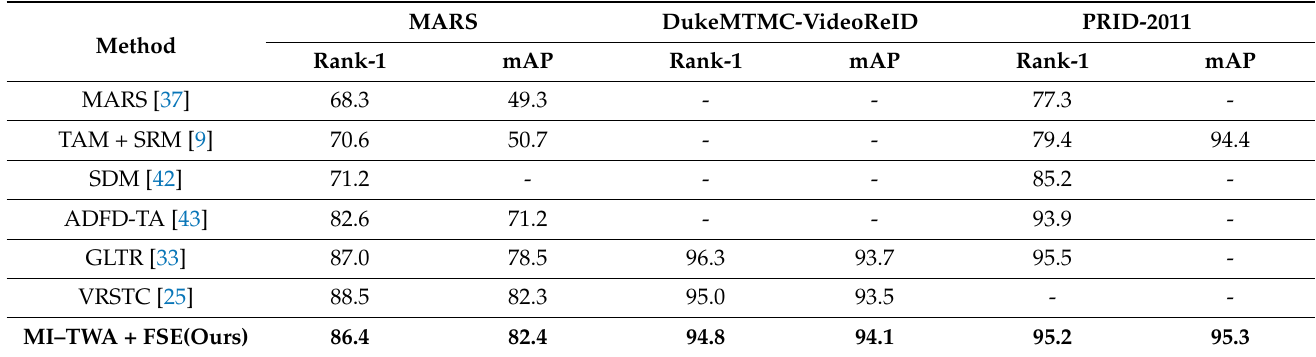
Table 6. Comparisons of our proposed approach to the state-of-the-art